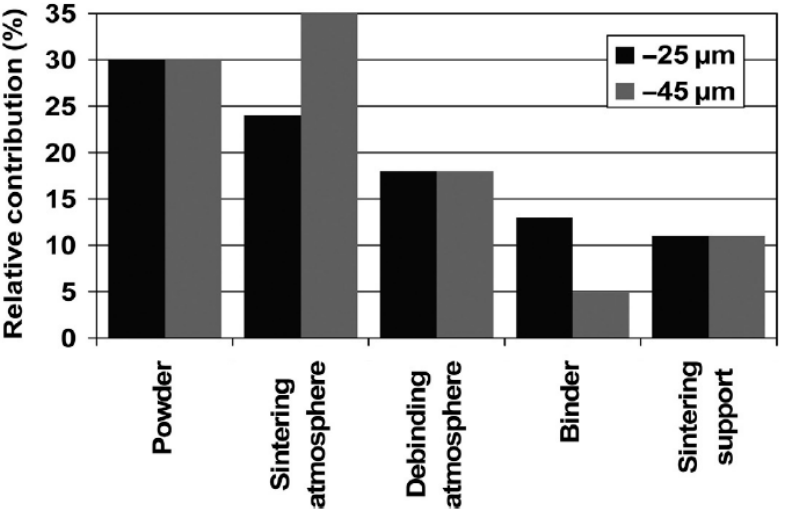
Figure 3. Contribution of each processing step to oxygen contamination in Ti powder subjected to MIM and sinter process. Reproduced with permission [36]. Copyright 2014, Taylor and Francis.